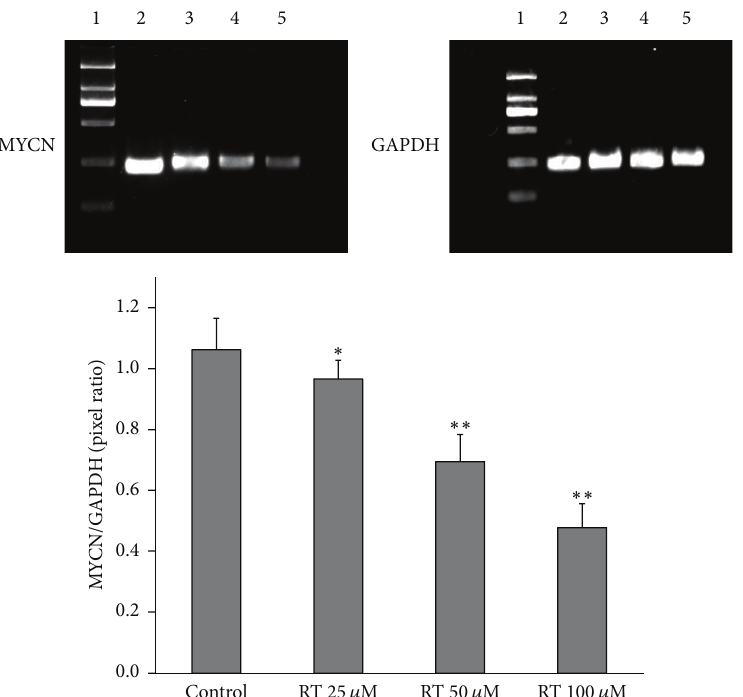
Figure 7: The effect of rutin on expression of MYCN. MYCN mRNA expression is high in normal cells, rutin significantly reduces MYCN mRNA expression in LAN-5. ∗ 𝑃 < 0.05 ; ∗∗ 𝑃 < 0.01 compared to control. 1: marker; 2: control; 3: RT 25 𝜇 M; 4: RT 50 𝜇 M; 5: RT 100 𝜇